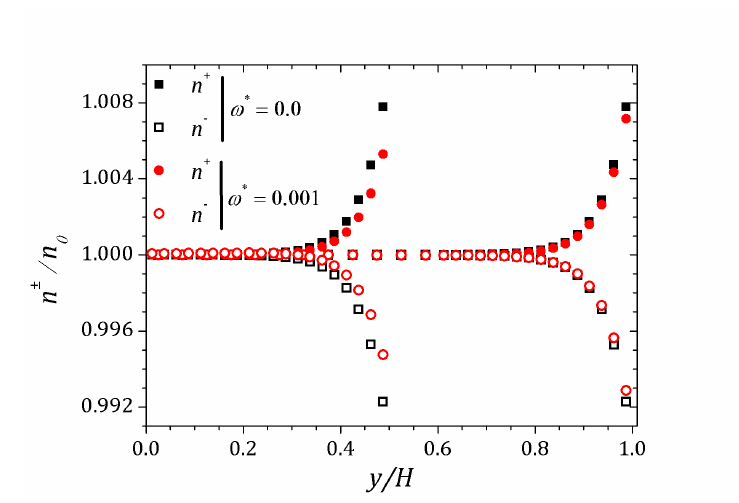
Figure 22. Ionic concentration n ± into the contraction and right after the expansion of the channel. Results for perturbation parameter ω ∗ = 0 and 1.0 × 10 − 3